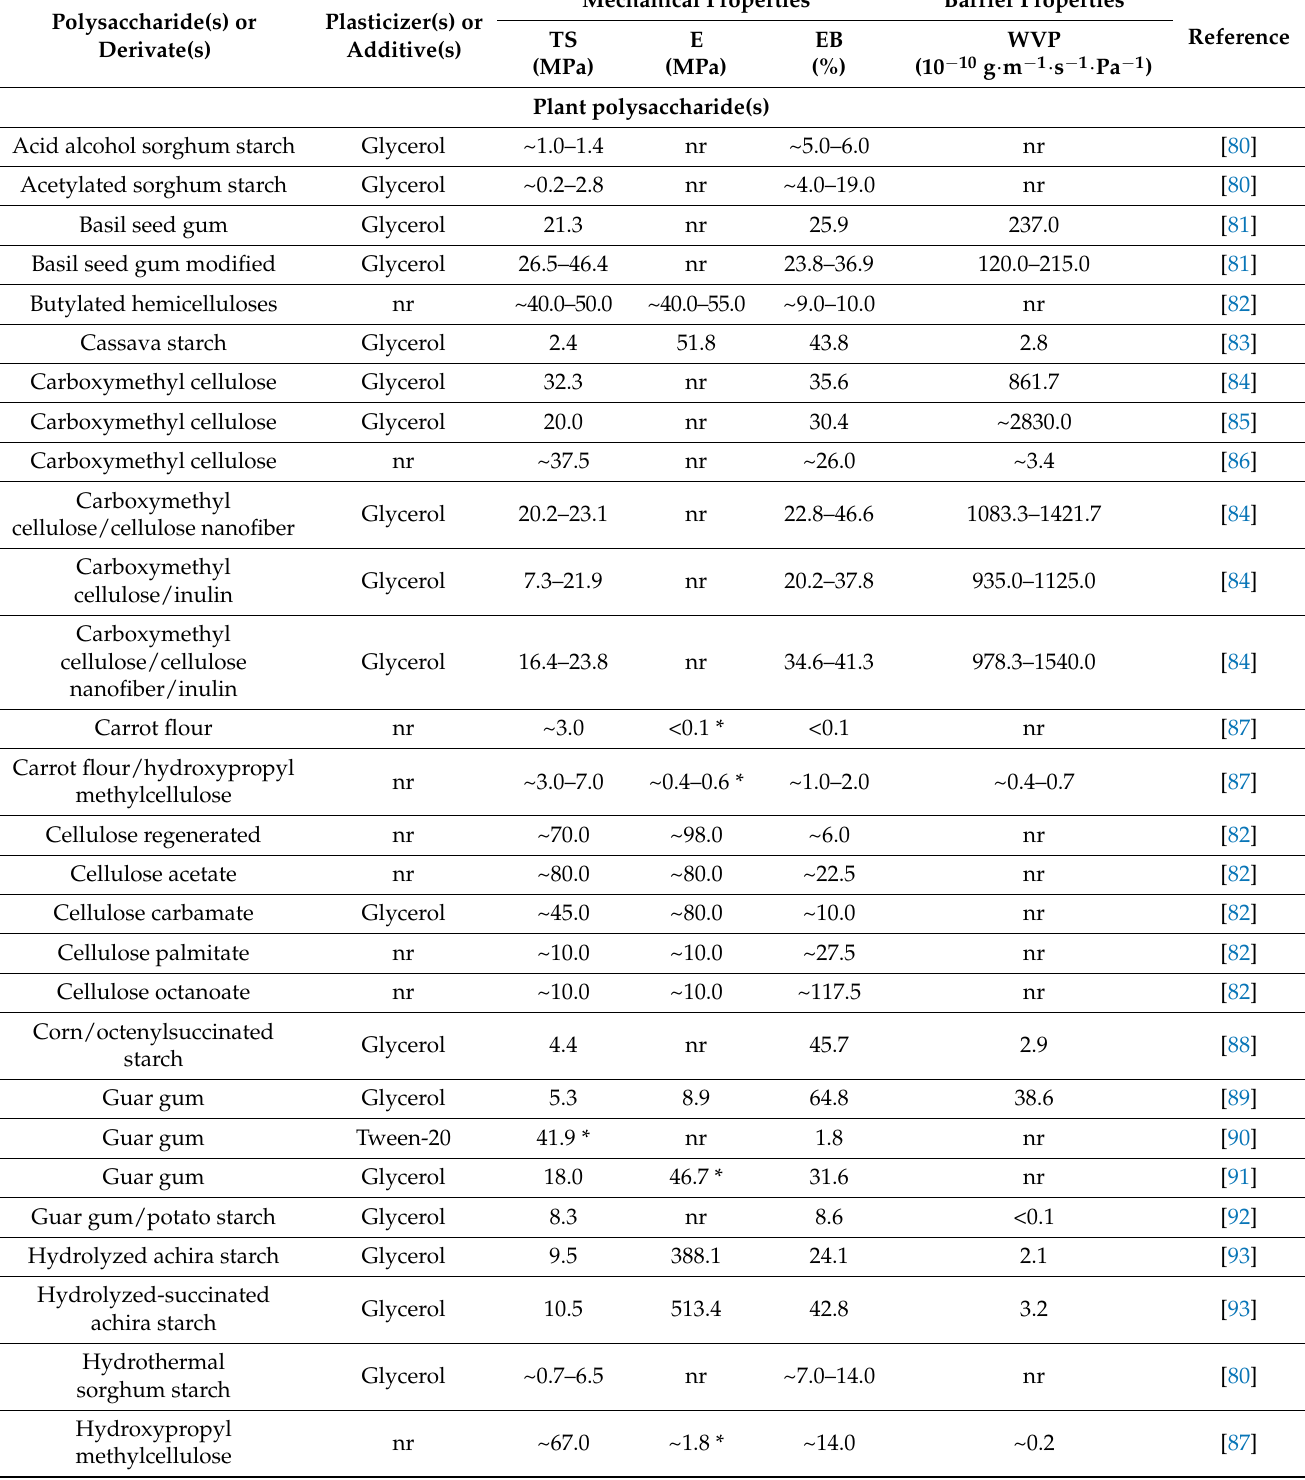
Table 1. Properties of biodegradable films based on